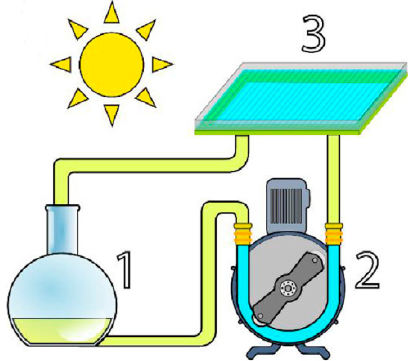
Figure 2. Schematization of the proposed solar photoreactor: 1—flask containing tartrazine solution; 2—peristaltic pump; and, 3—photoreactor containing the PM (Aoudjit et al. [42]). 2—peristaltic pump; and, 3—photoreactor containing the PM (Aoudjit et al.